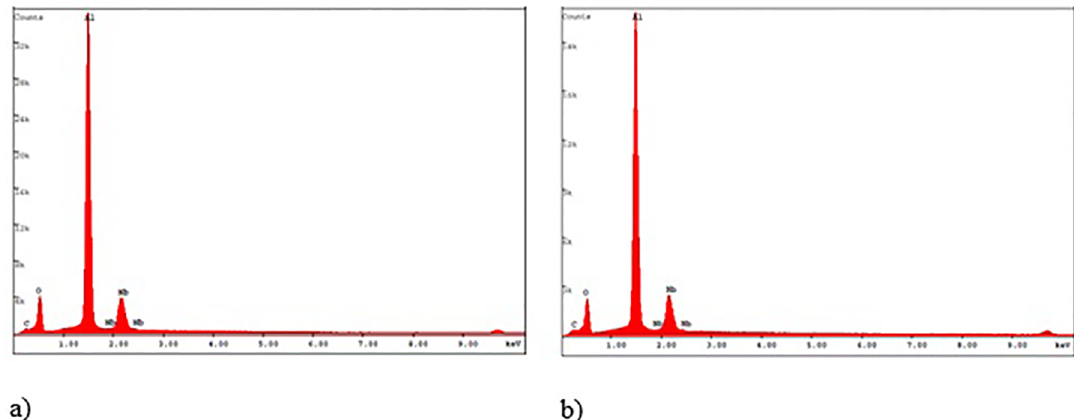
O in 95% Al O , Area 1 (a) and Area 2 (b) x y 2 3